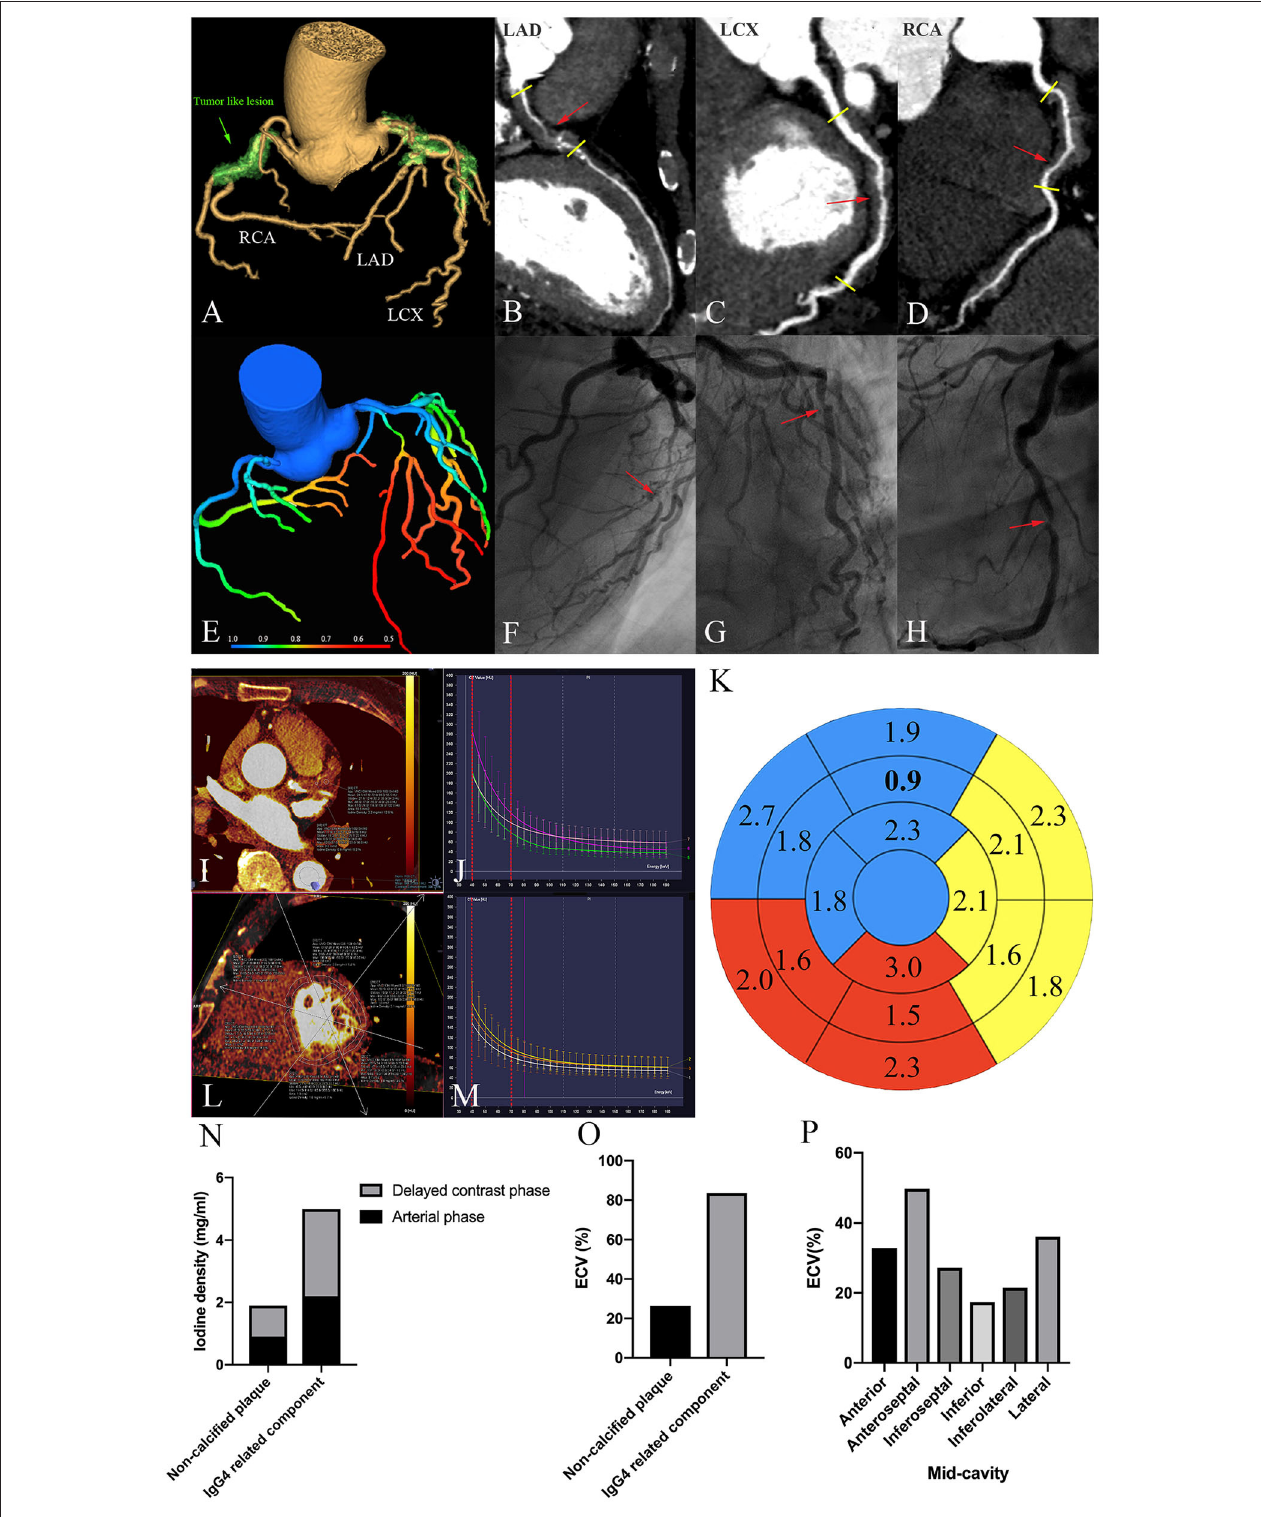
FIGURE 1 | Multimodality imaging of IgG4-RD involving the coronary artery. (A) 3D volume-rendered-reconstructed CCTA demonstrates tumor-like lesions involving the RCA, LAD, and LCX (a green arrow). (B–D) Curved planar reformation of the CCTA. The red arrow indicates the most severe stenosis. The short yellow line